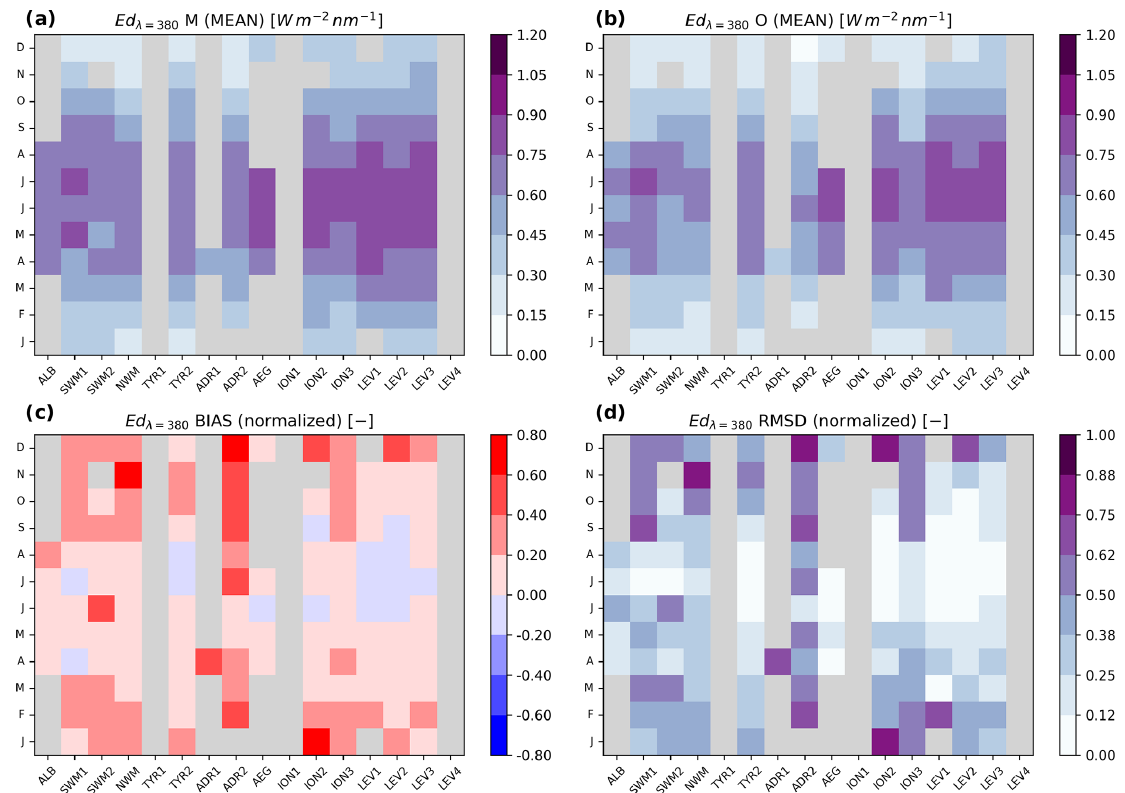
Figure 8. Results of the match-up between the model ( M ) and BGC-Argo float observations ( O ) for E d (λ = 380 , 0 − ) , aggregated spatiotem- porally based on the climatological months and 16 sub-basins. The top figures show the mean values of the model ( M , a ) and observations ( O , b ). Bias and RMSD are shown in (c) and (d) , respectively. The unit is watts per square metre per nanometre, and bias and RMSD are dimensionless due to the normalization by the average values. The grey colour represents the points in space and time for which fewer than five match-ups were